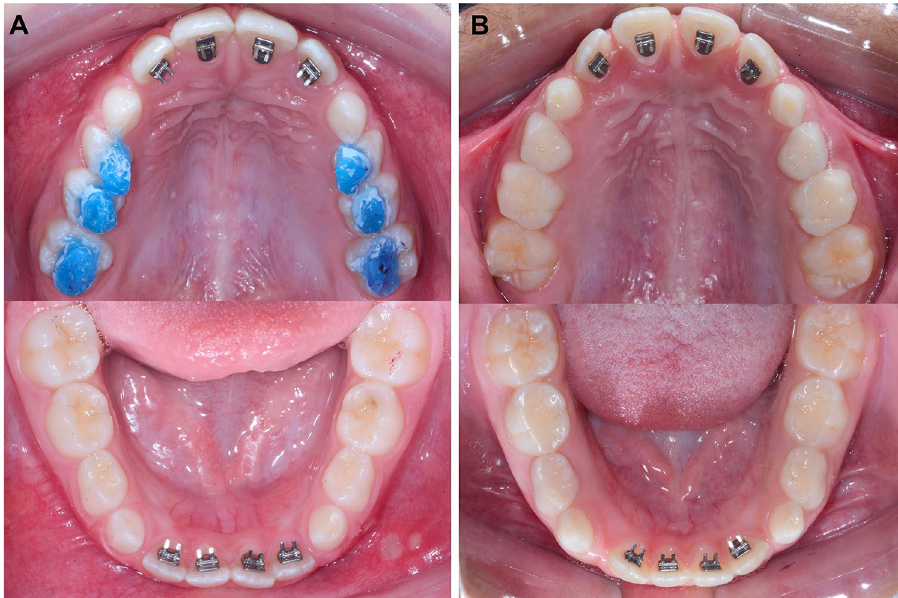
Figure 1. ( A ) Experimental group treated with bonded spurs and posterior build-ups. ( B ) Comparison group treated only with bonded